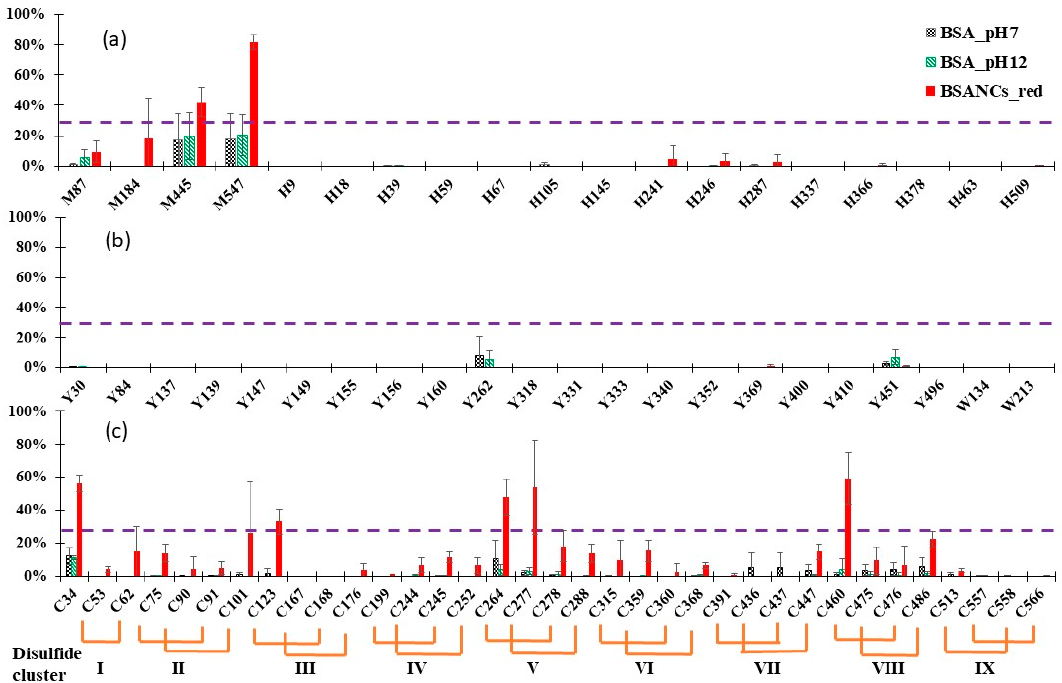
Figure 2. Global oxidization percentage of all ( a ) methionine and histidine residues, ( b ) tyrosine, tryptophan, and ( c ) cysteine residues of BSA, detected from BSA solution under pH 7 and pH 12, as well as BSA-AuNC solution. Each data point was the average of three independent measurements with ± 1 standard deviation (error bar). Connections of disulfide pairs are indicated in the bottom of ( c ).